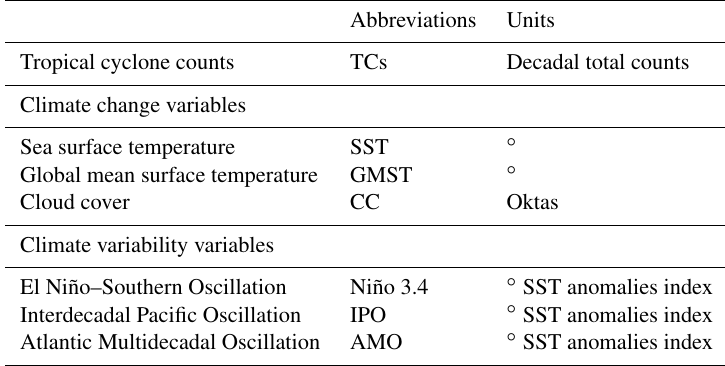
Table 1. Tropical cyclone, climate change and variability variables used in this